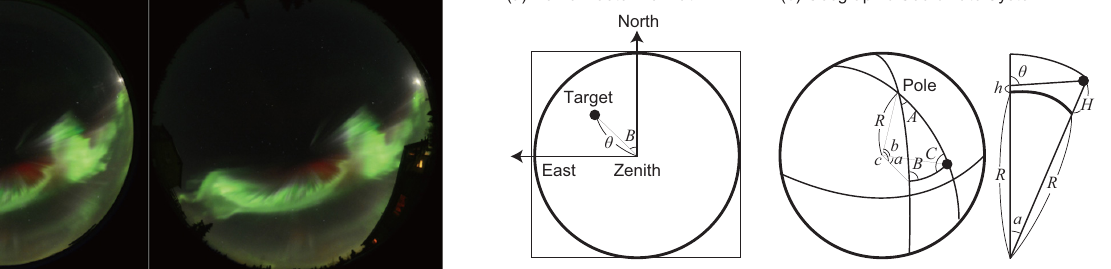
Fig. 1. All-sky images of ray structure of discrete aurora as obtained from (left) Poker Flat Research Range and from (right) Aurora Bo- realis Lodge at 09:17UT on 17 March 2013. Camera settings are ISO6400 and 2s exposure time. The center of images is the zenith, geographic north is to the top, and west is to the right.